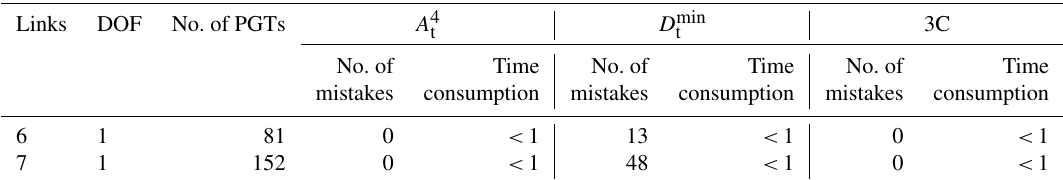
Table 3. Detection results of PGTs.